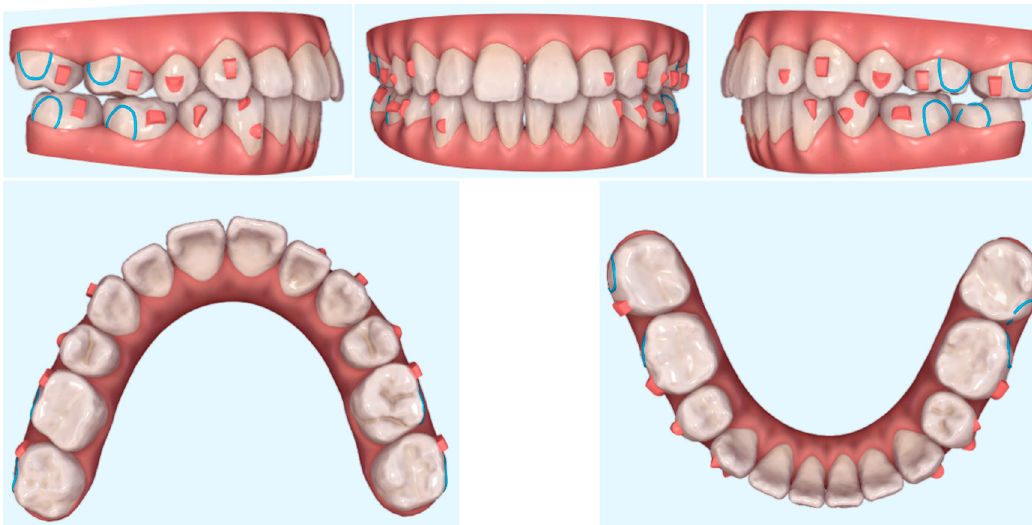
Figure 6. Refinement stage: ClinCheck treatment plan (Align Technology, Santa Clara, CA,